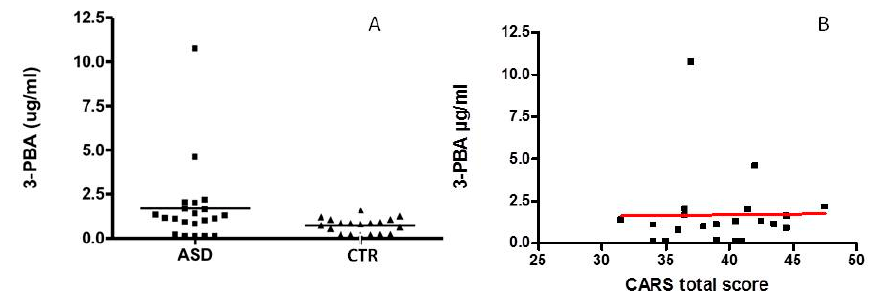
Figure 1. ( A ) 3-PBA level in urine in ASD and Control groups (CTR); ( B ) correlation between CARS total score and 3-PBA levels.